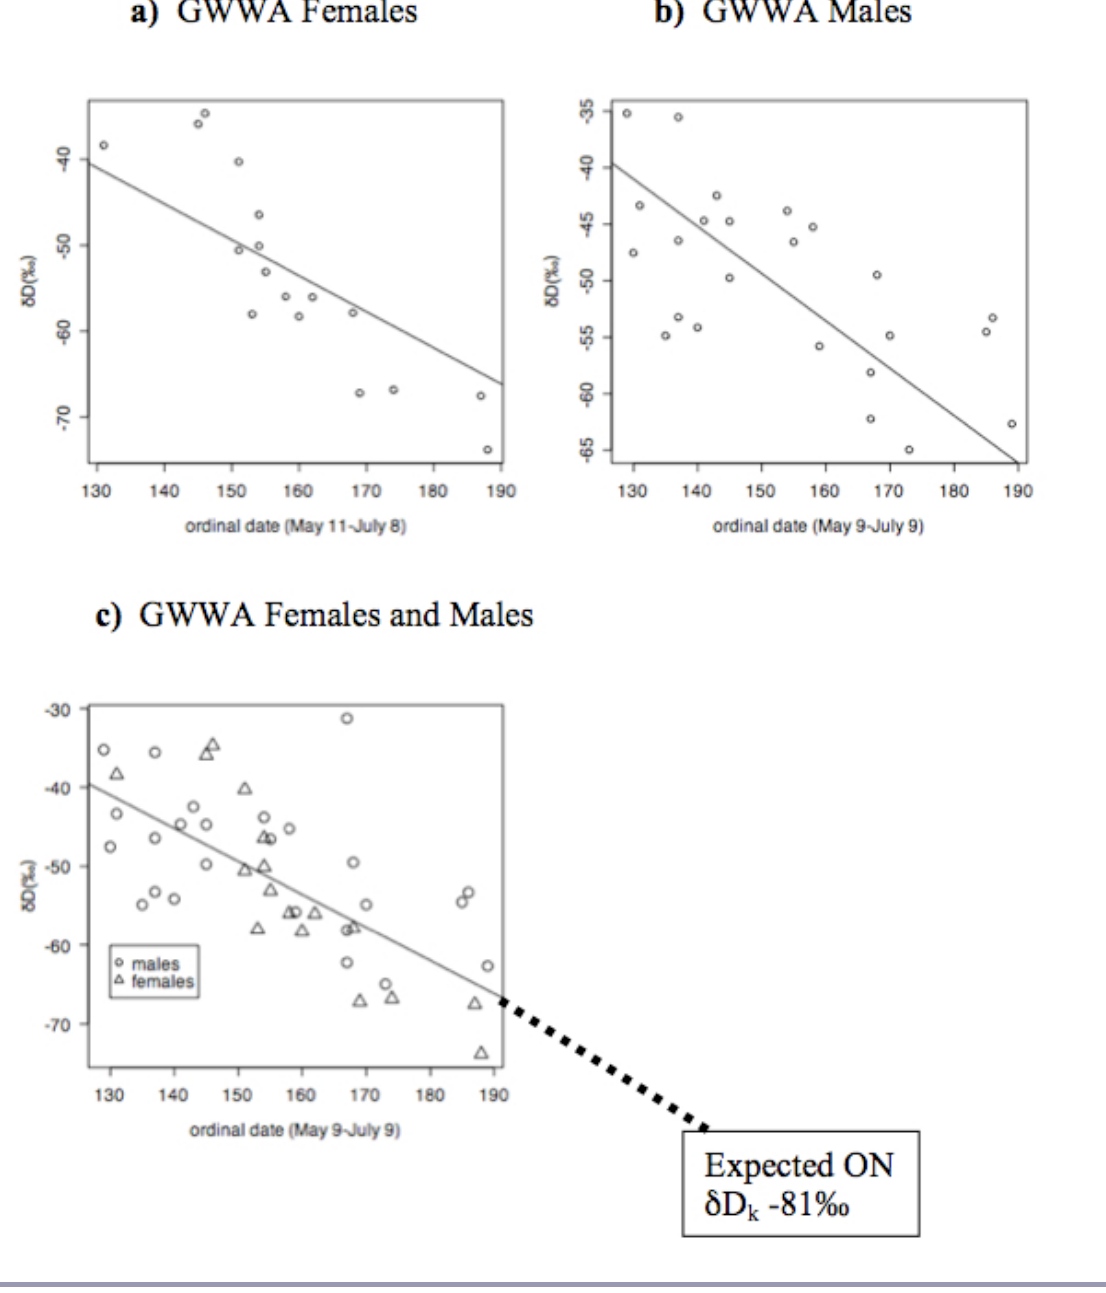
Fig. 1. The relationship between d D values of Ontario Golden-winged Warbler claws (a–c; females n = k 17, males n = 25) and ordinal date shows a 0.4‰ per day shift toward locally expected values. The solid line represents a least-squared linear